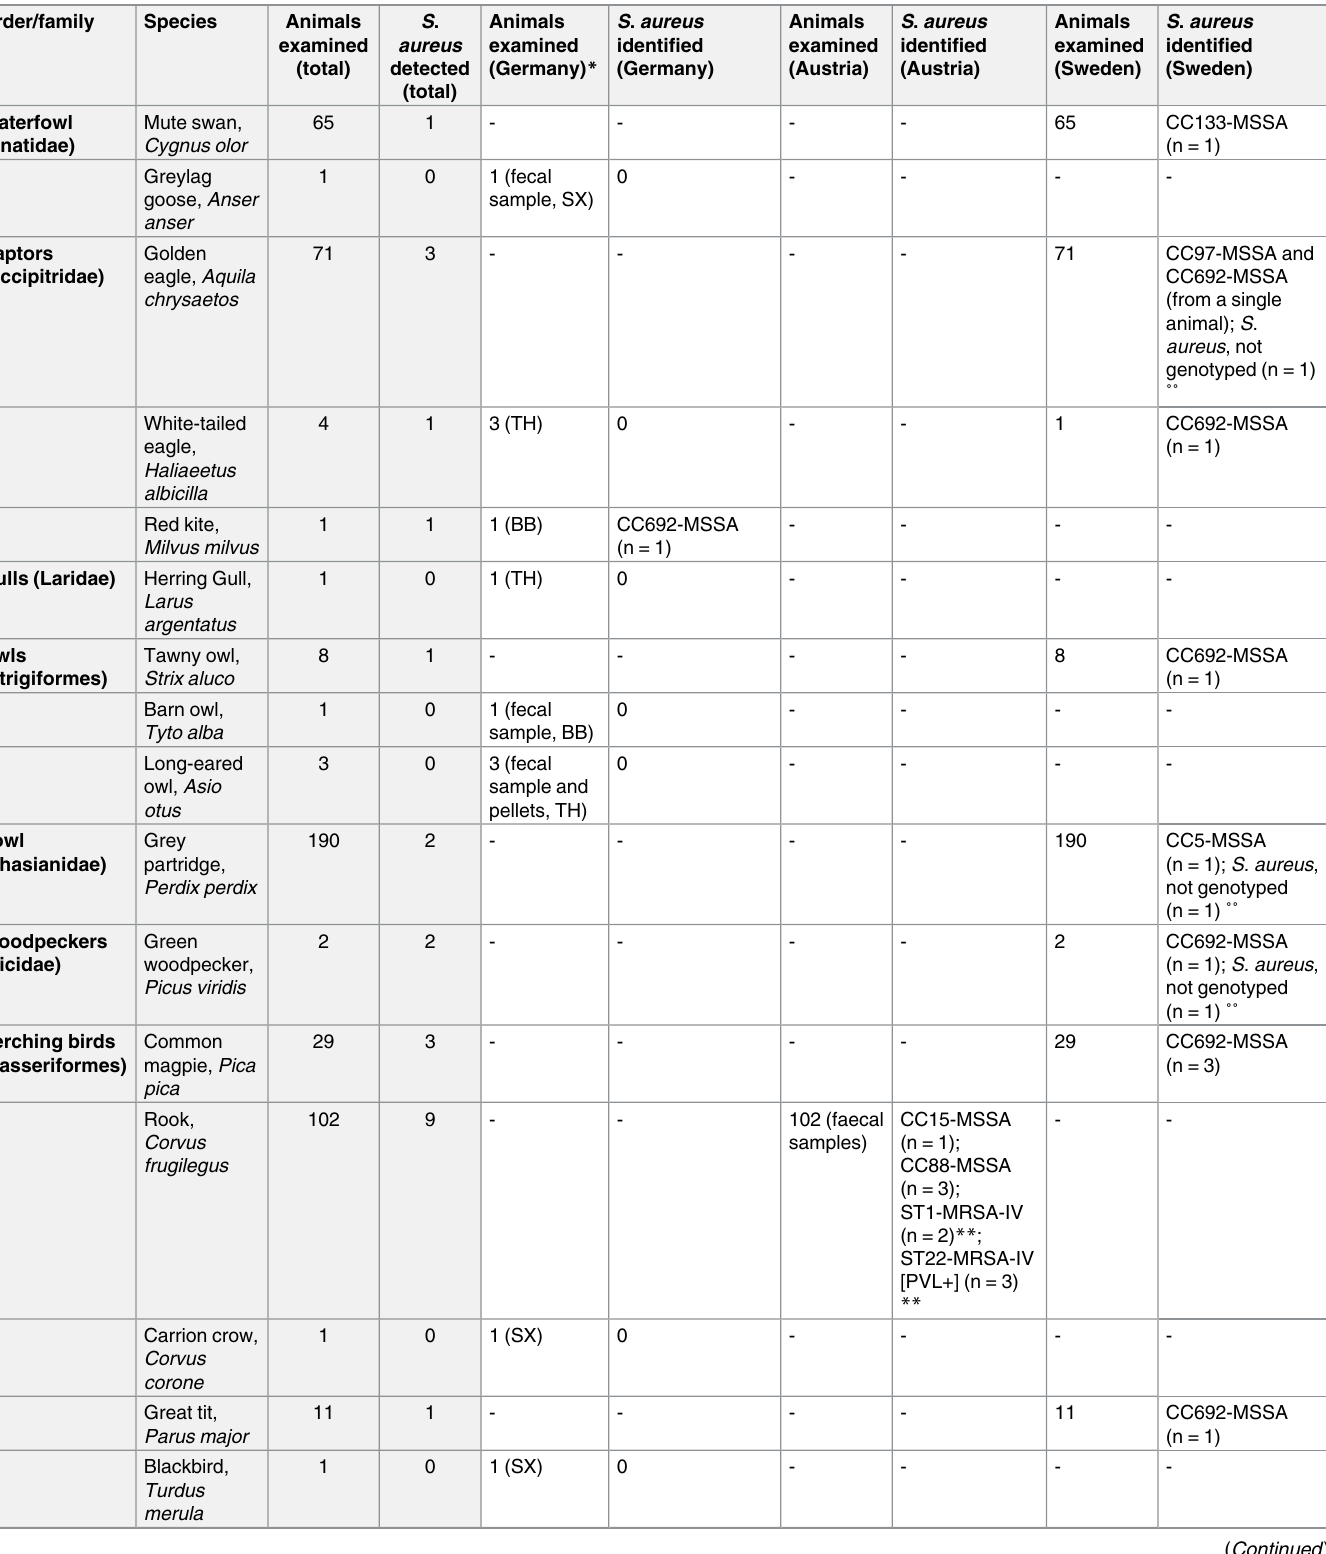
Table 1. Detection of S . aureus by country and host species.